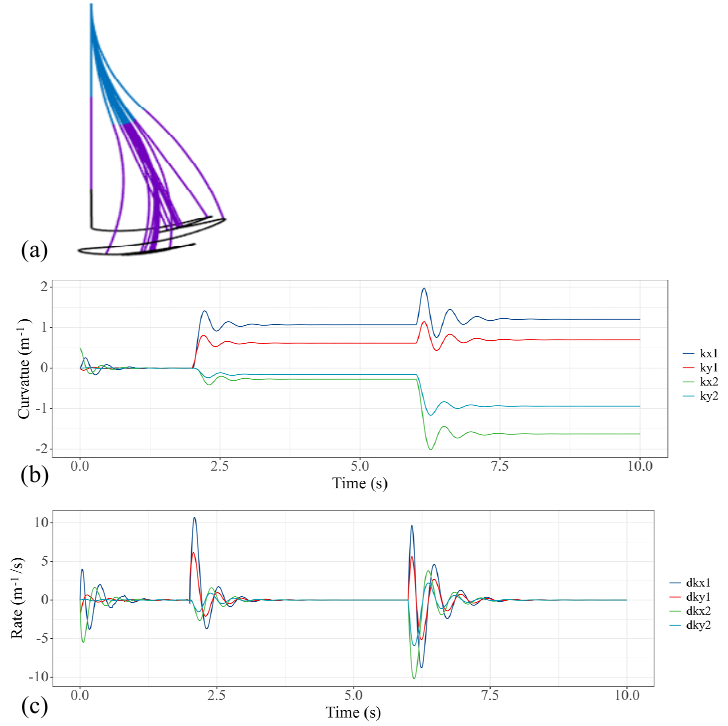
Figure 7. Simulation results of the soft manipulator when the first and fourth actuators are actuated by step torque. ( a ) Soft manipulator trajectory versus time. ( b ) Curves of the bending curvature versus time. ( c ) Curves of speed versus time.